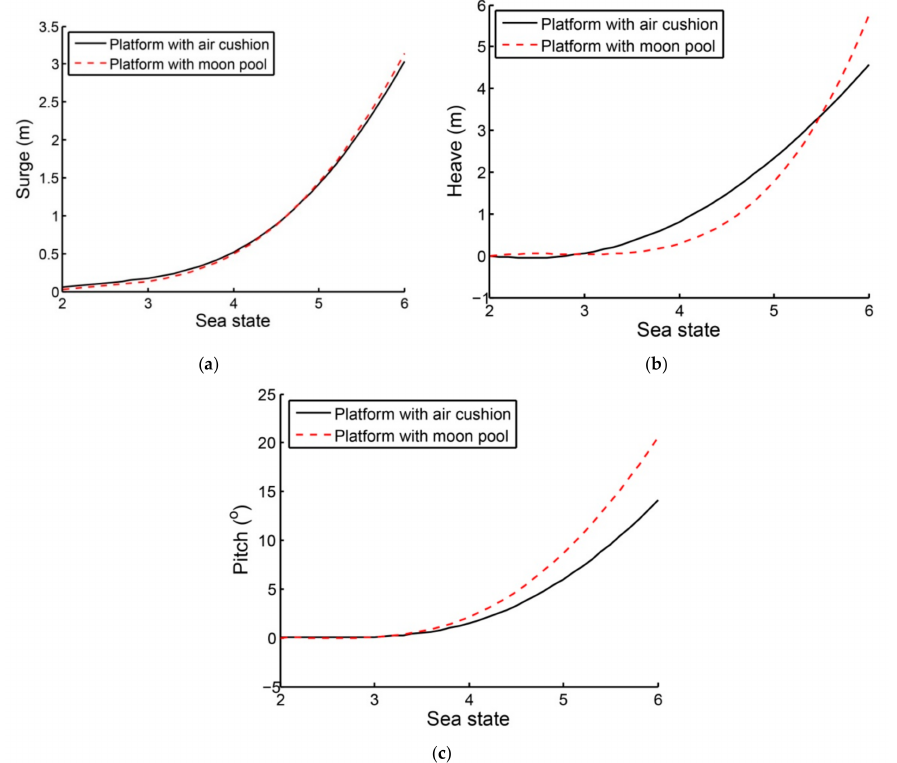
Figure 9. Significant value of motion response of the platforms in irregular waves. ( a ) Surge; ( b ) heave; ( c )